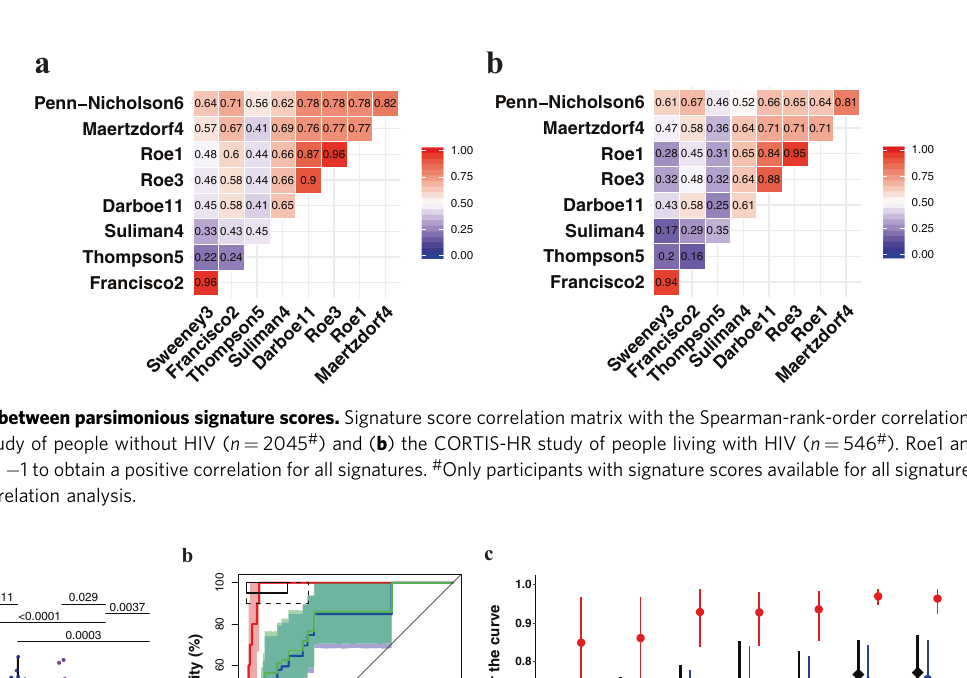
Table S10 in Supplementary Data 1). Primary endpoint diagnostic